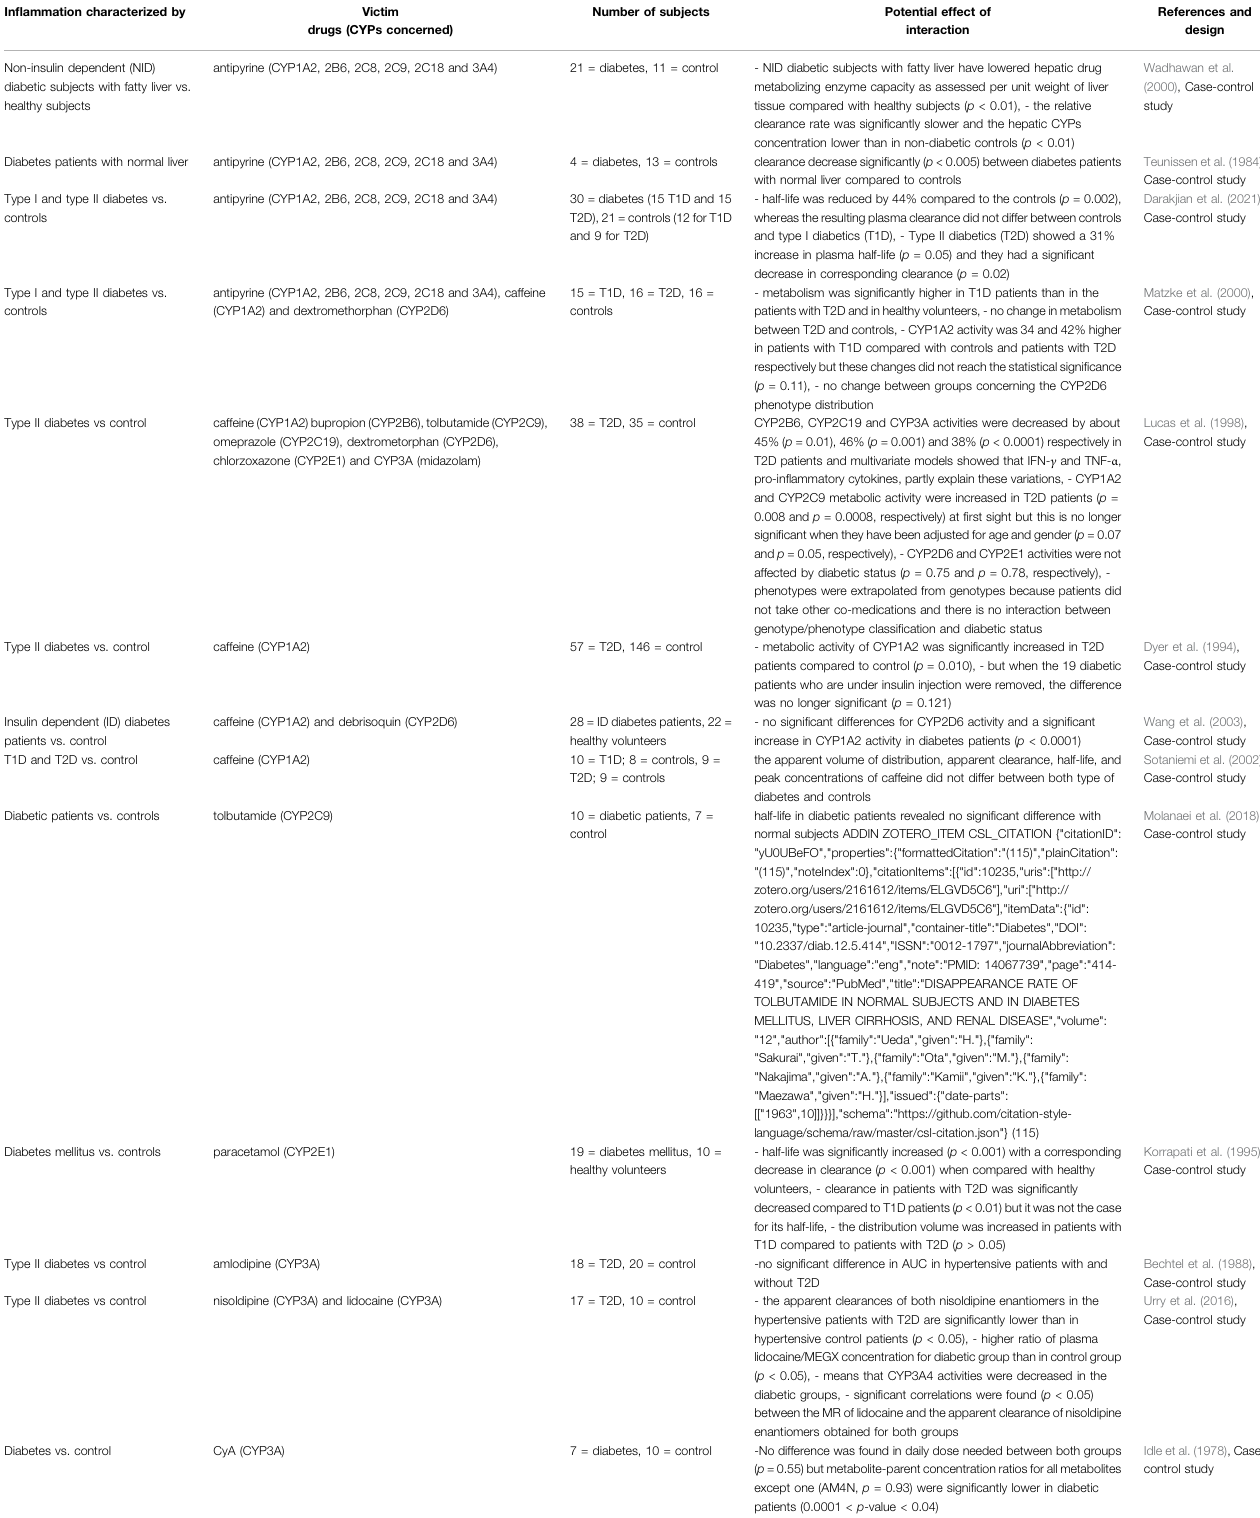
TABLE 9 | Impact of diabetes on CYP substrates, explained totally or partially by modulation of CYP activity. In fl ammation characterized